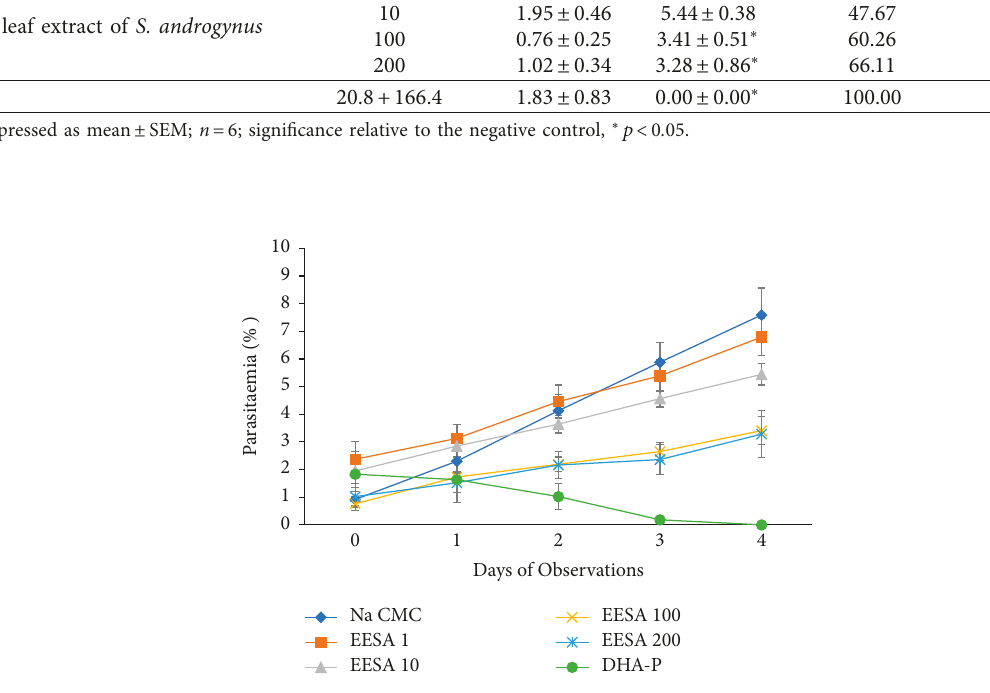
Figure 2: The effect of ethanolic leaf extract of S. androgynus on percent parasitemia of P. berghei -infected mice on 4-day suppression test. Data are expressed as mean ± SEM; n � 6; DHA-P � dihydroartemisinin-piperaquine, EESA � ethanolic extract; numbers refer to doses in Table 3: Percentages of inhibition of parasite growth in mice infected with P. berghei treated orally by doses of ethanolic leaf extract of S. androgynus for four consecutive days before infection ( D 0 − D 3 ).